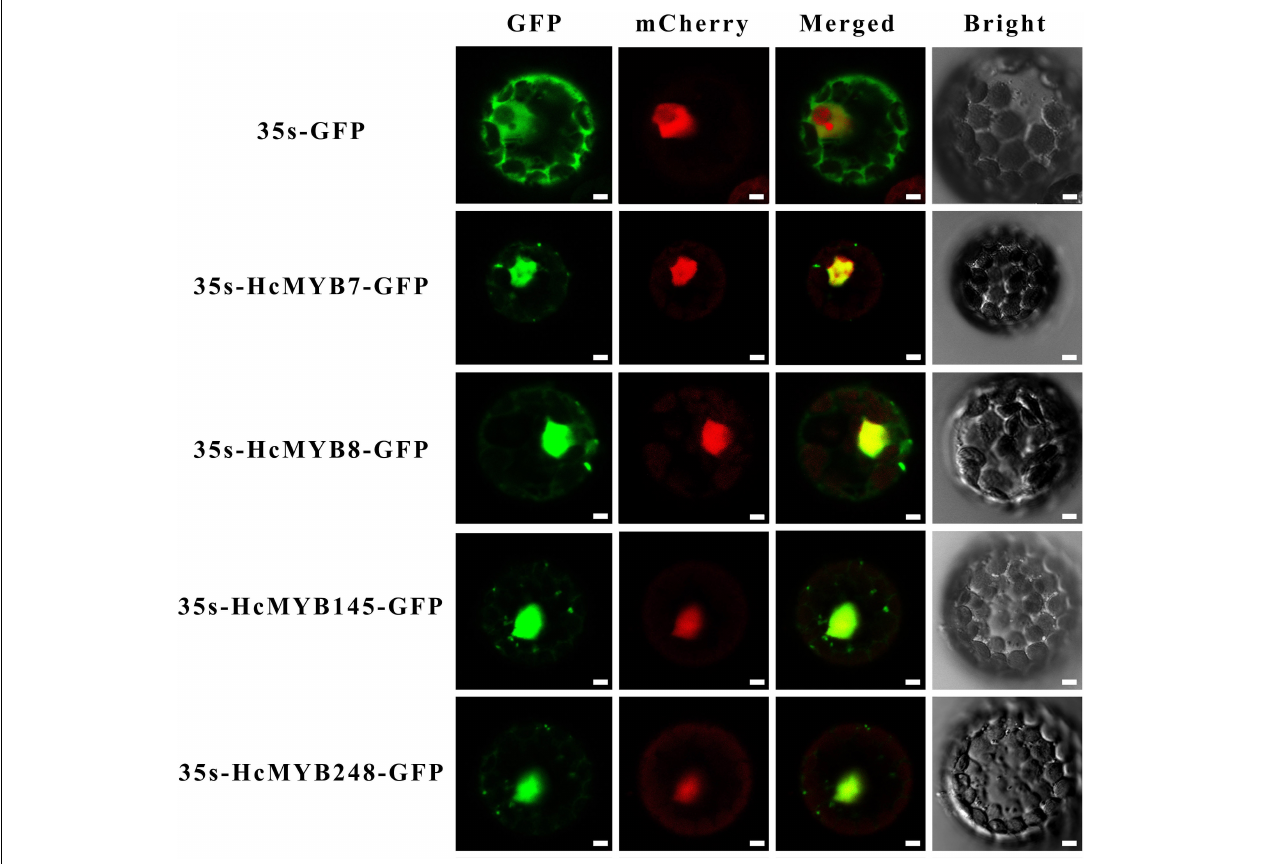
FIGURE 5 | Nuclear localization of HcMYB7/8/145/248 proteins in Arabidopsis protoplasts. GFP; green fluorescent protein, mCheyy; nuclear marker, merged; combined mCheryy and GFP and bright field. Bars, 10 µ